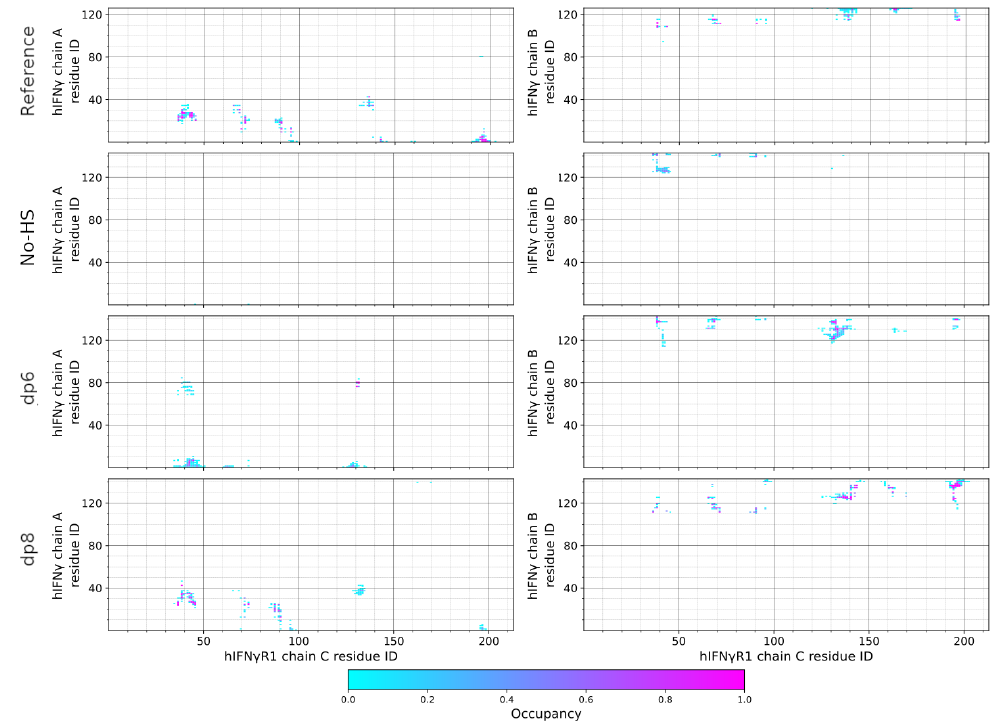
Figure 3. Contact maps between the two hIFN γ monomers (chain A and B) and receptor subunit C.